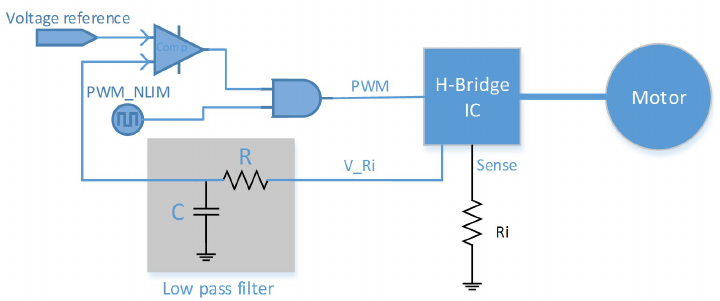
Figure 11. The current measurement and limiting